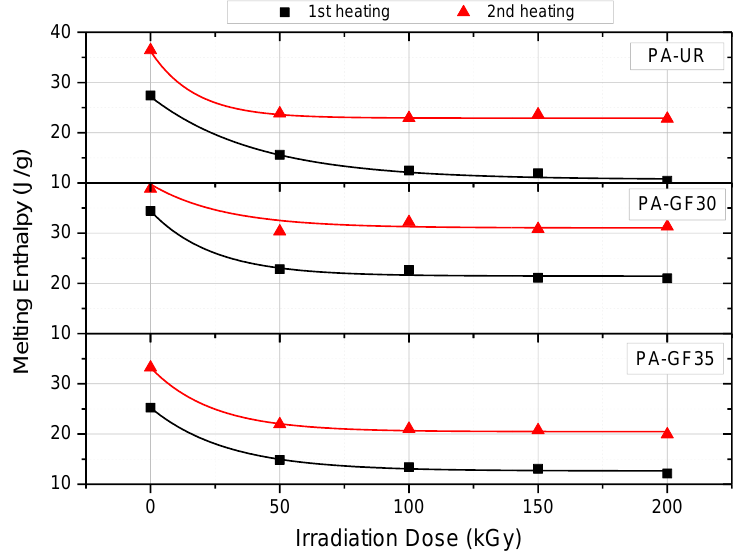
Figure 4. Melting enthalpy as a function of irradiation dose of three different PA grades for the first and second heating run.